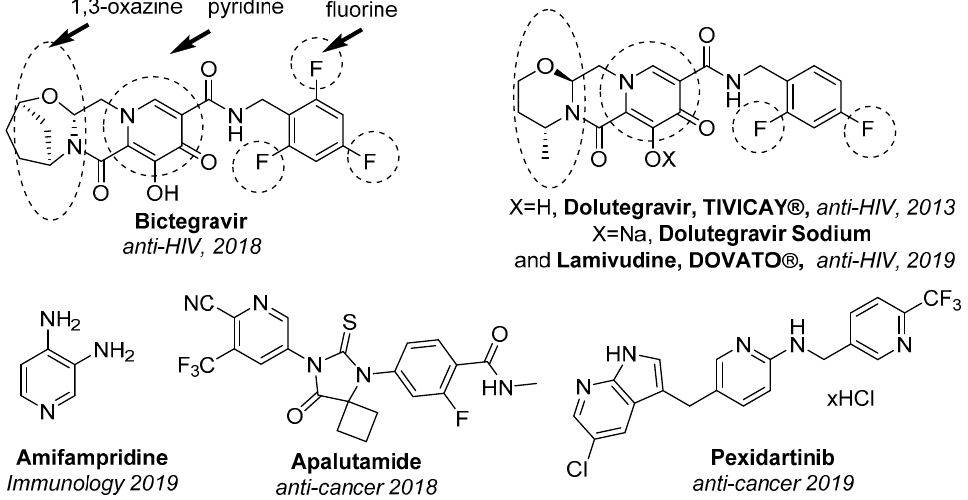
Figure 1. Selected FDA approved drugs in 2018 and 2019 containing pyridine moiety, fluorine atoms, 1,3-oxazine moiety.